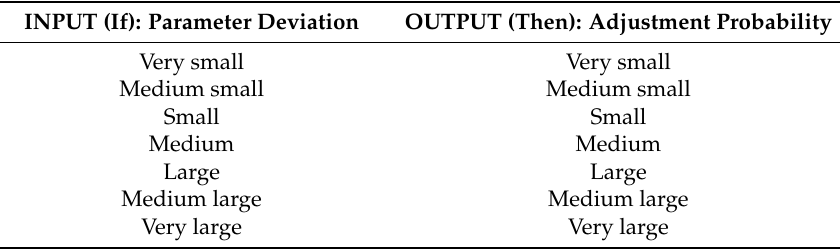
Table 3. The Fuzzy